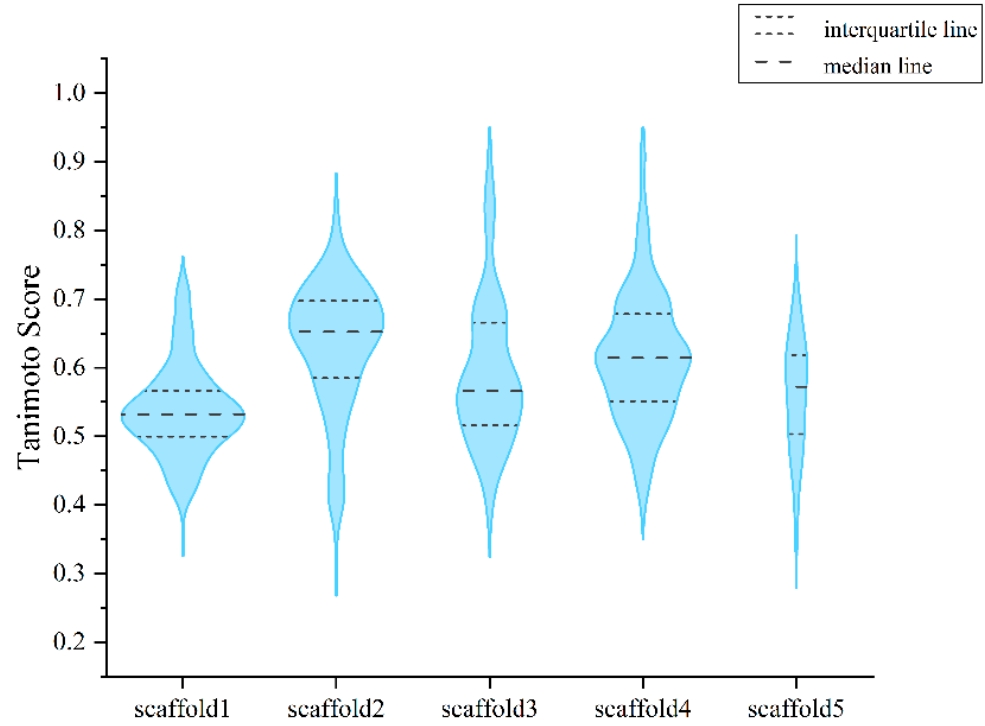
Figure 6. Similarity distribution of generated molecules and known active compounds. Distribution of closest similarity values between the generated compound and the known active compound.